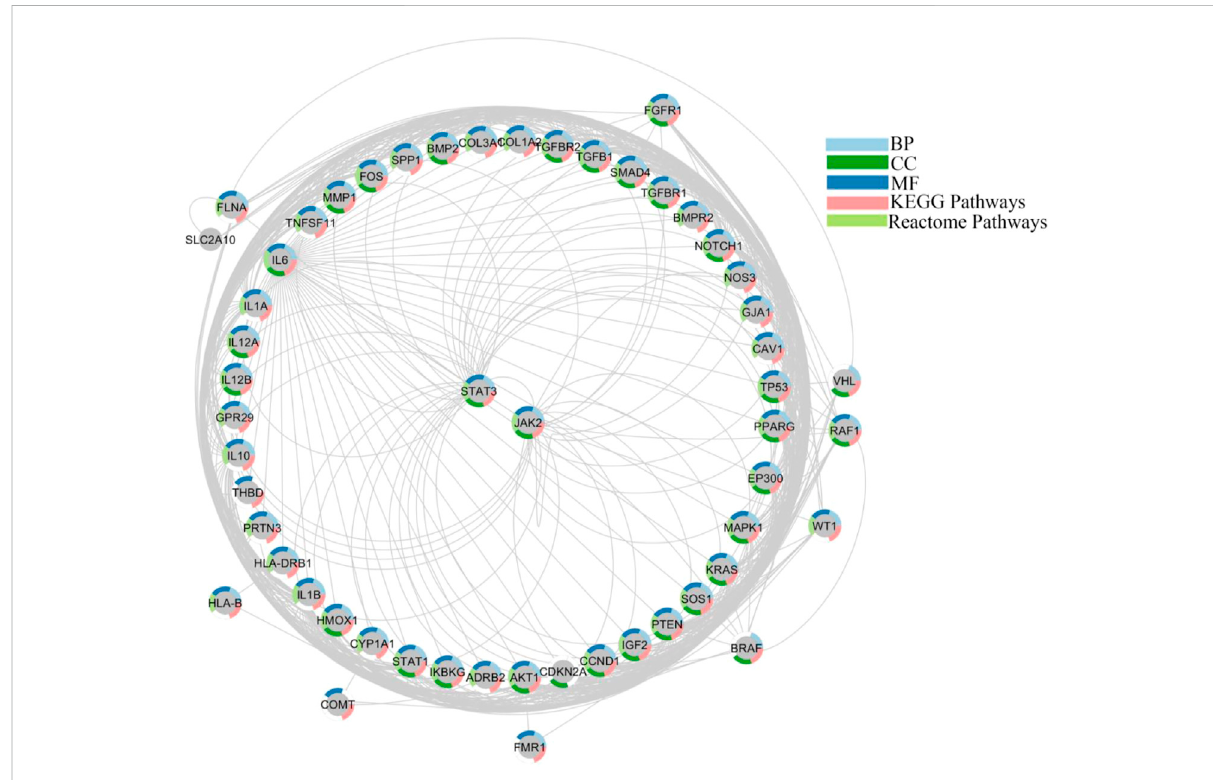
FIGURE 4 Networkingoftarget-functionevaluation.Afunctionalcomponentofinterconnectedtargetsisrepresentedinapiechartwithdifferentcolorsif either the target is actively engaged in GO processes as well as pathways.